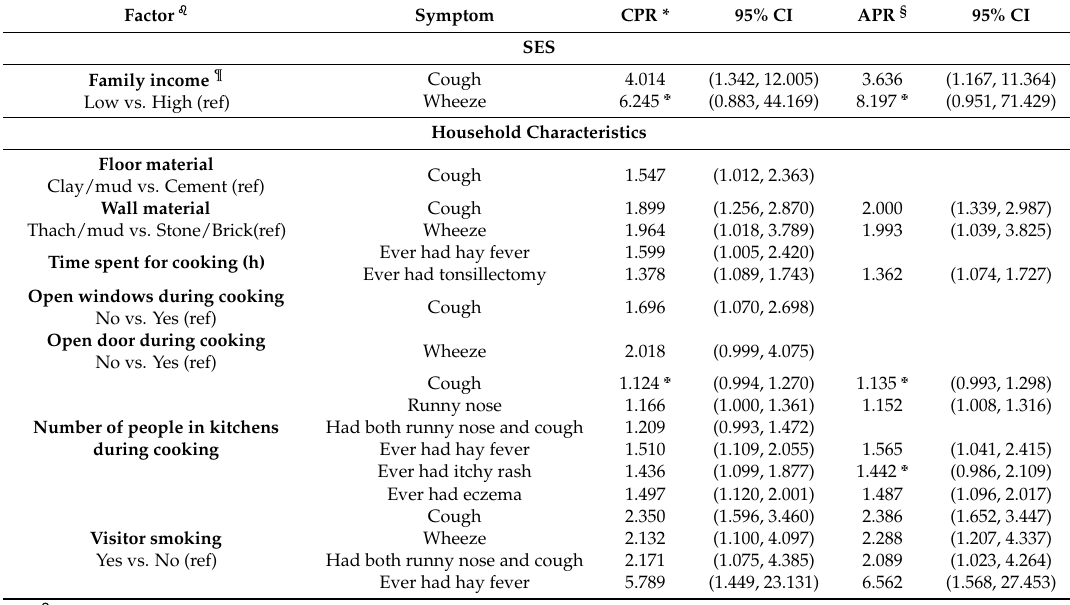
Table 4. Association between socioeconomic status, household characteristics, occupant activities, and prevalence of respiratory symptoms among mothers.